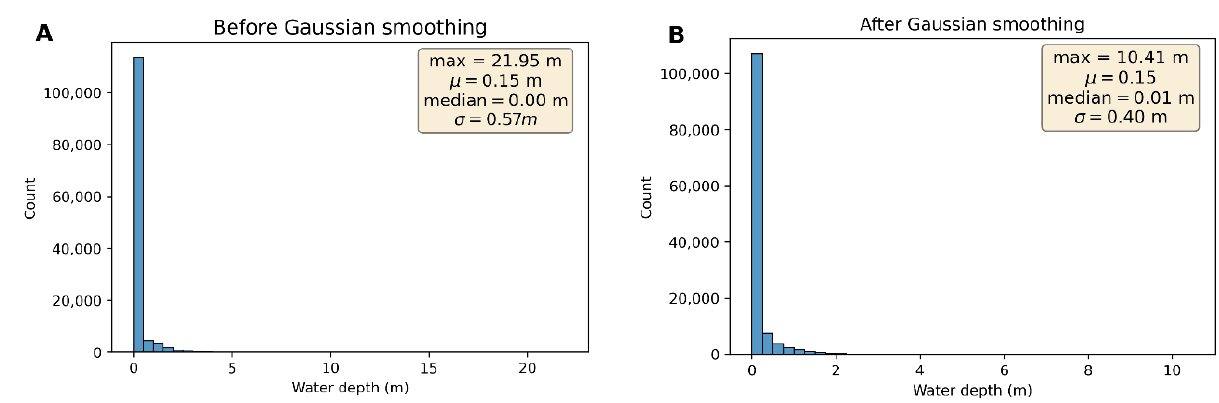
Figure 7. Histograms of the dependent variable (water depth): ( A ) before smoothing; ( B ) after smoothing.